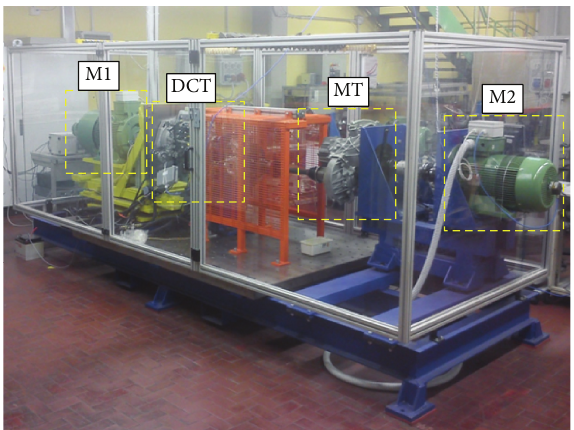
Figure 1: Transmission test bench at the Politecnico di Torino.